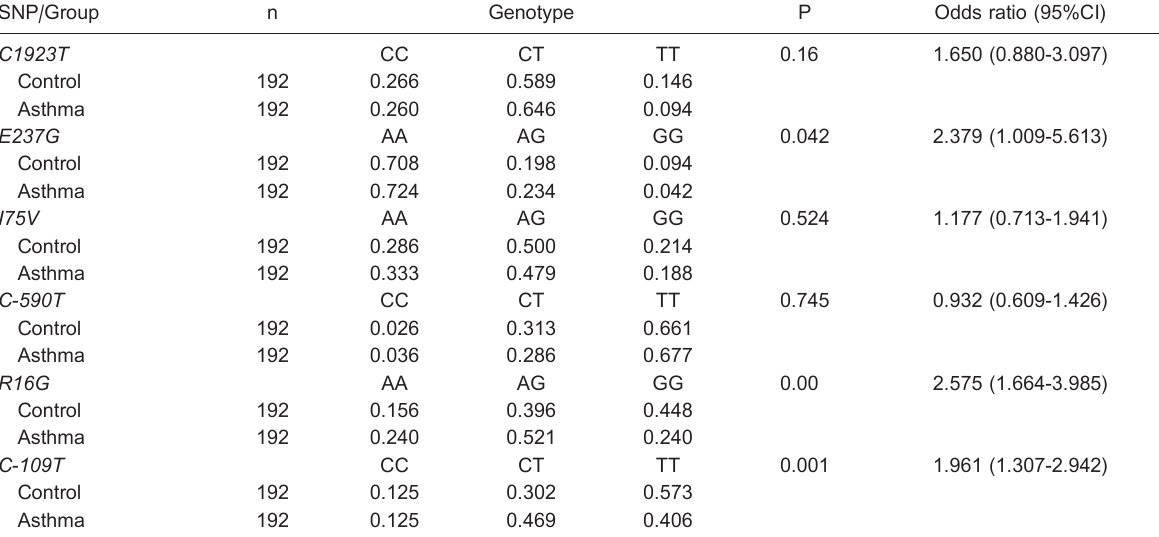
Table 2. Distribution of SNPs in the Chinese Han population. SNP/Group